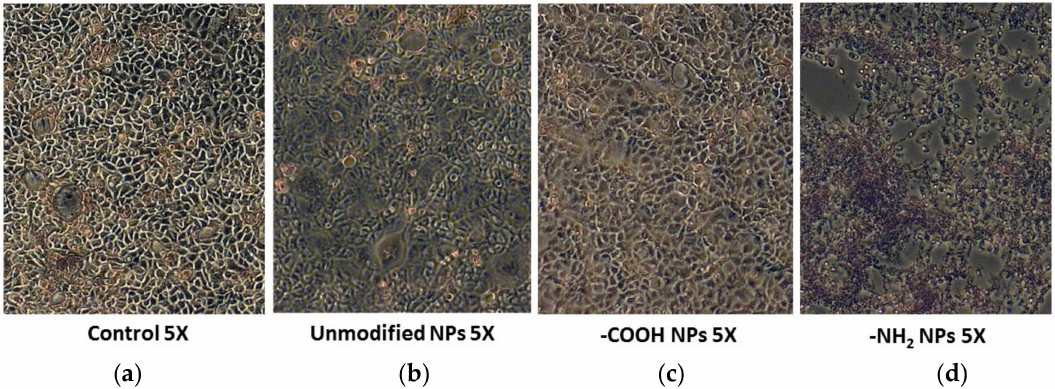
Figure 5. Effect of polystyrene nanoparticles on Caco-2 visualized by optical microscopy. Caco-2 cells in the ( a ) abscense and presence of ( b ) unmodified; ( c ) -COOH functionalized; and ( d ) -NH 2 functionalized NPs showing the cytotoxic effect of the positively charge